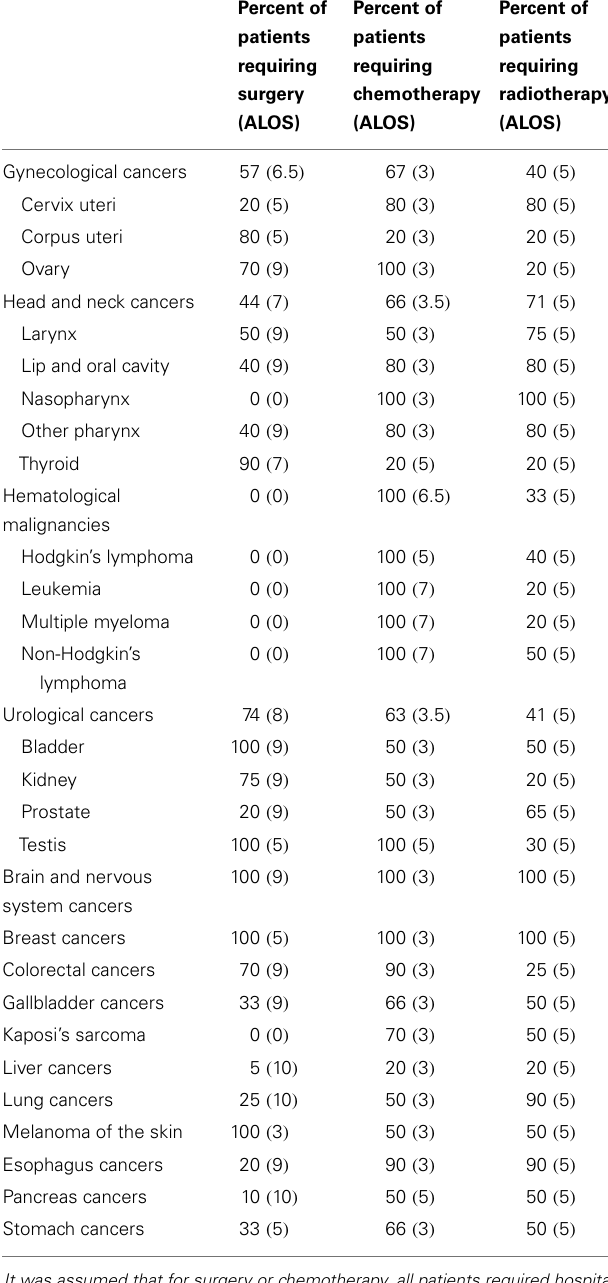
Table 2 |The percentage of requiring patients various kinds of treatment and their average length of stay (ALOS) in hospital (in days)